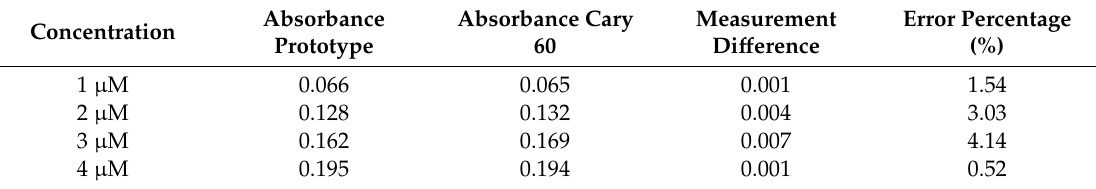
Table 5. Measurements of mercury concentration.